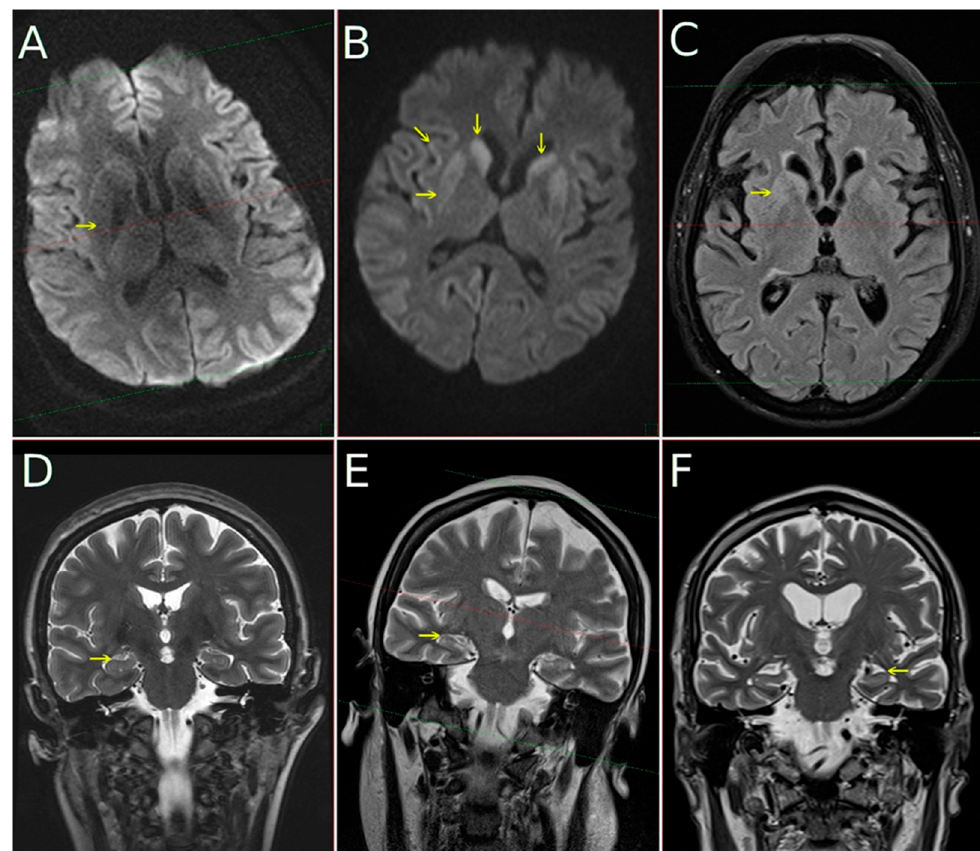
Figure 1. MRI in CJD subjects performed at 1.5T field strength: diffusion-weighed images (( A , B ), DWI) with b-factor 1000, FLAIR image ( C ), coronal T2-weighted images ( D – F ). In the first column ( A , D ) data from subject with pure CJD—no DWI hyperintensity in putamina (arrow) is present and MTA is 0 (read as normal). In the second column ( B , E ) subject with tau comorbidity with mild hippocampal atrophy (MTA 1, arrow on ( E )) and DWI ( B ) hyperintensity in putamina (horizontal arrow), caudates (vertical arrows) and with cortical ribboning (oblique arrow). In the third column ( C , F ) subject with CJD and AD comorbidity is shown. A moderate hyperintensity is visible not only on DWI (not shown), but as well on FLAIR image ( C ). Hippocampal atrophy is well pronounced, MTA 2 (arrow from right side of the ( F ), pointing to the left hippocampus which manifests clear